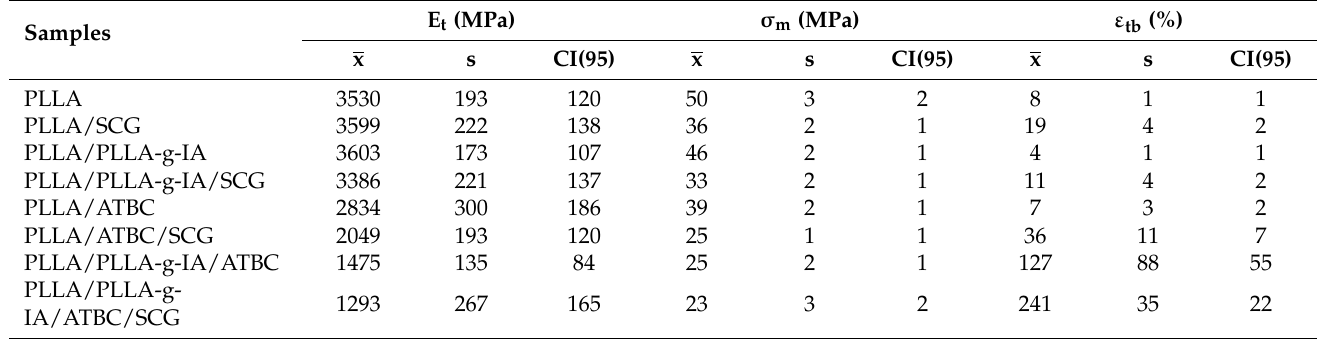
Table 7. Tensile modulus, strength, and elongation at break of PLLA-based